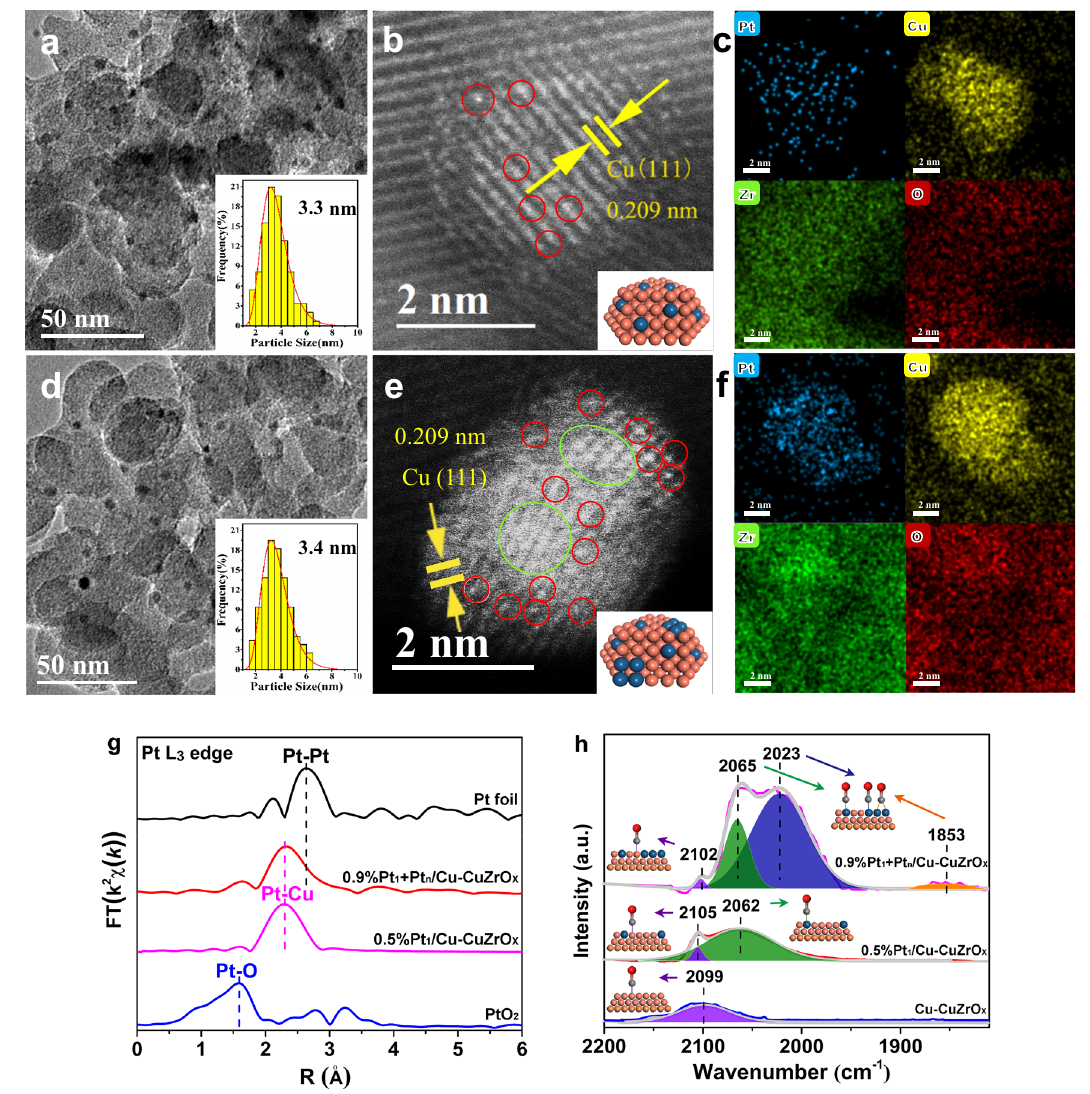
Fig. 2 | Pt dispersion state and coordination con fi guration. a – f Representative HRTEM images ( a , d ), AC-HAADF-STEM images ( b , e ), and HADDF-STEM-EDS ele- mentmappings( c , f )of0.5%Pt 1 /Cu-CuZrO x ( a – c )and0.9%Pt 1 +Pt n /Cu-CuZrO x ( d – f ).